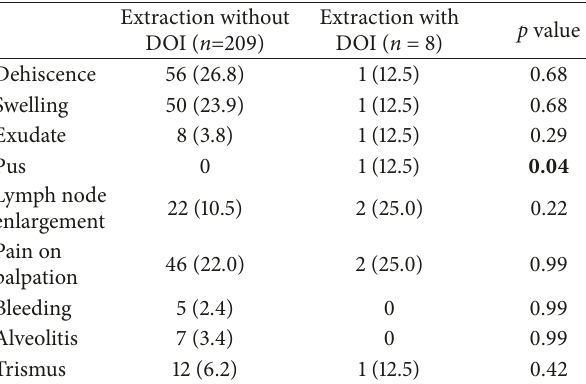
Table 4: Clinical features recorded at 𝑇 1